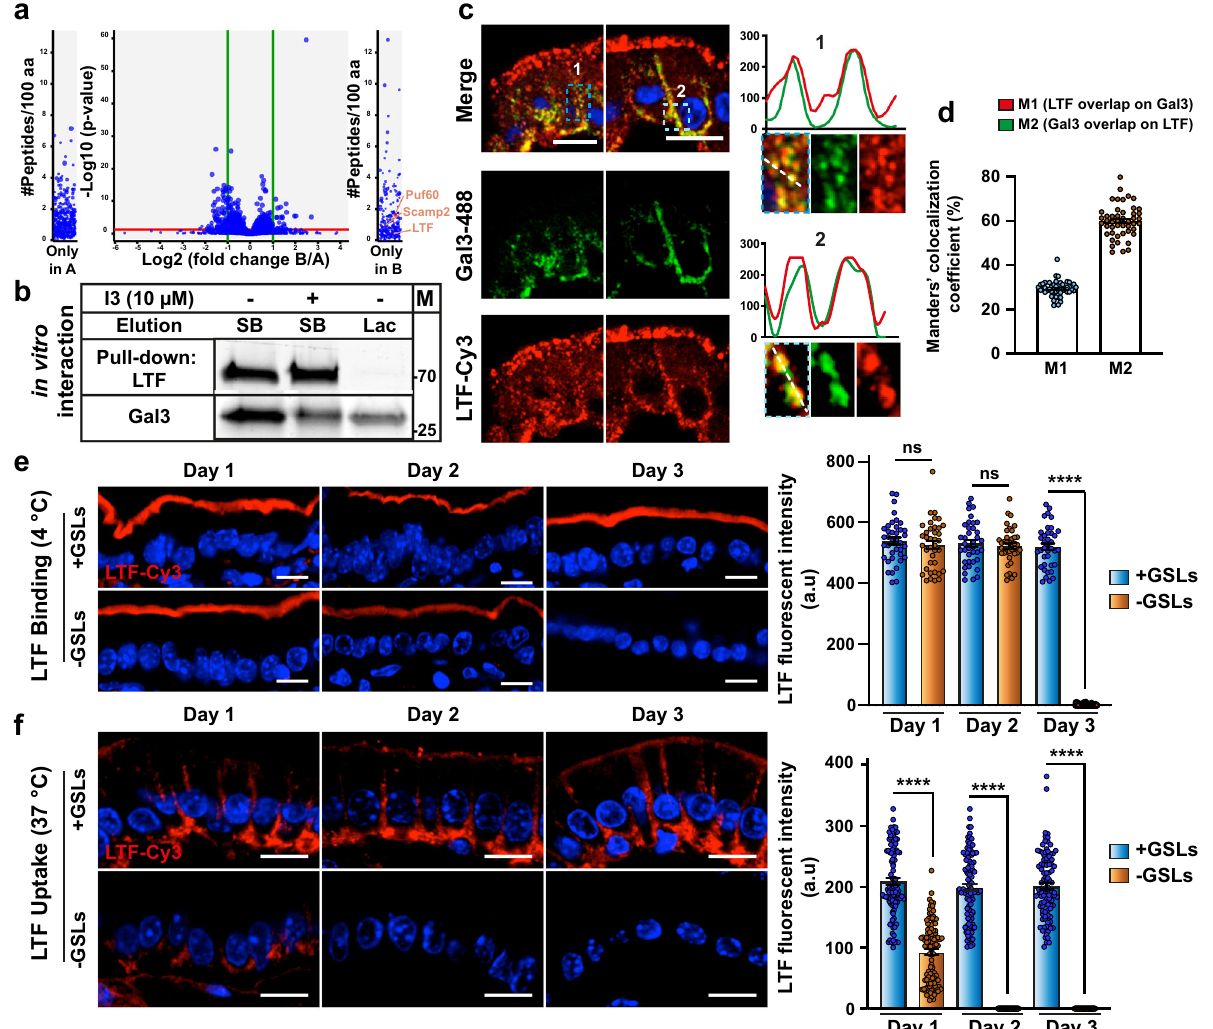
Fig. 6 LTF transcytosis is GSL-dependent. a Identi fi cation of LTF as a Gal3 interacting protein in enterocytes of the jejunum of wild-type C57BL/6 mice. Top: Quantitative analysis of proteins present in Gal3 ( = B) samples compared to PBS control ( = A) is shown as a volcano plot. x axis = log2 (fold change Gal3/PBS), y axis = − log10 ( P value). The horizontal red line indicates P value = 0.05, vertical green lines indicate absolute fold change = 2. Data represent the results of three independents pull-down experiments. Proteins are shown with at least one peptide in each of the Gal3 replicates, and zero peptide in the PBS control replicates in the qualitative comparison without Match-between-Runs-rescued peptides. b Pull-down experiment on cobalt – agarose beads of puri fi ed LTF-His and Gal3-Cy3. Note that Gal3 is co-puri fi ed with LTF in a Gal3 inhibitor (I3)-dependent manner, and speci fi cally eluted with lactose (one representative of two independent experiments). M = PageRuler ™ prestained protein ladder (the position of bands 25 and 70 kDa is shown in the gel). c In total, 20 µ g/mL of Gal3-488 (green) and LTF – Cy3 (red) were co-incubated for 30 min at 37 °C with DTT-permeabilized jejunum. Note the strong overlap between both markers. d Mander ’ s coef fi cient (%) analysis con fi rms colocalization between Gal3 and LTF, strongly suggesting that both proteins are co-internalized (mean percentage ± SEM, n = 42 cells). e At days 1, 2, or 3 after TAM injection, DTT-permeabilized jejunum of Ugcg fl ox/ Cre − ( + GSLs) or Ugcg fl ox/Cre + (-GSLs) mice was incubated at 4 °C with 20 µ g/mL of LTF – Cy3 (red). Note that LTF binding to the apical surface was similar in all conditions, with the exception of day 3 after TAM injection where it dropped to background levels. Right: Quanti fi cation of apical signal (means ± SEM, n = 38 cells per condition, 1 representative of 4 independent experiments). f Experiment as in ( c ), except that incubation, was performed for 30 min at 37 °C. LTF endocytosis was strongly reduced already at day 1 after TAM injection and dropped to background levels at days 2 and 3. Right: Signal quanti fi cation (means ± SEM, n = 102 cells per condition, one representative of four independent experiments). Nuclei in blue. Statistical analysis in ( c )